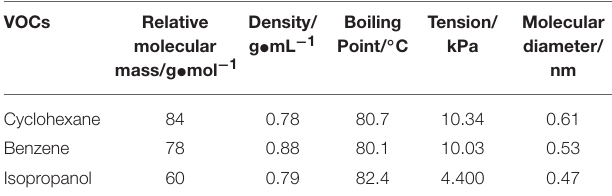
TABLE 4 | Physical parameters of VOCs.